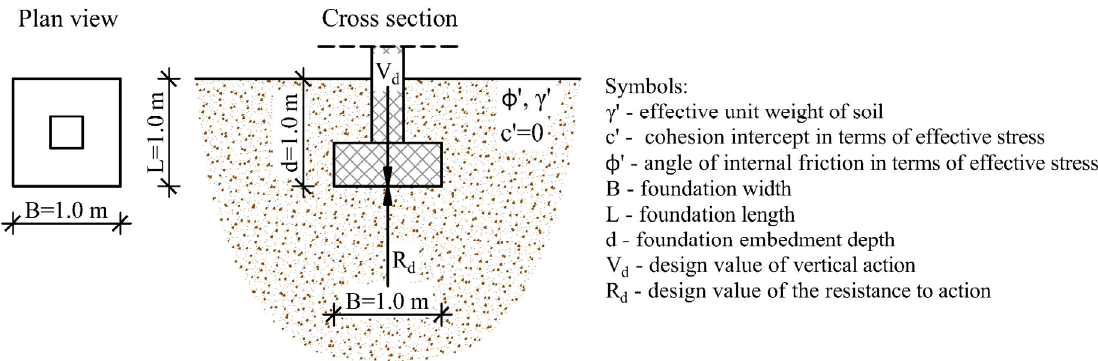
Figure 2. Reliability analyses geometry model.